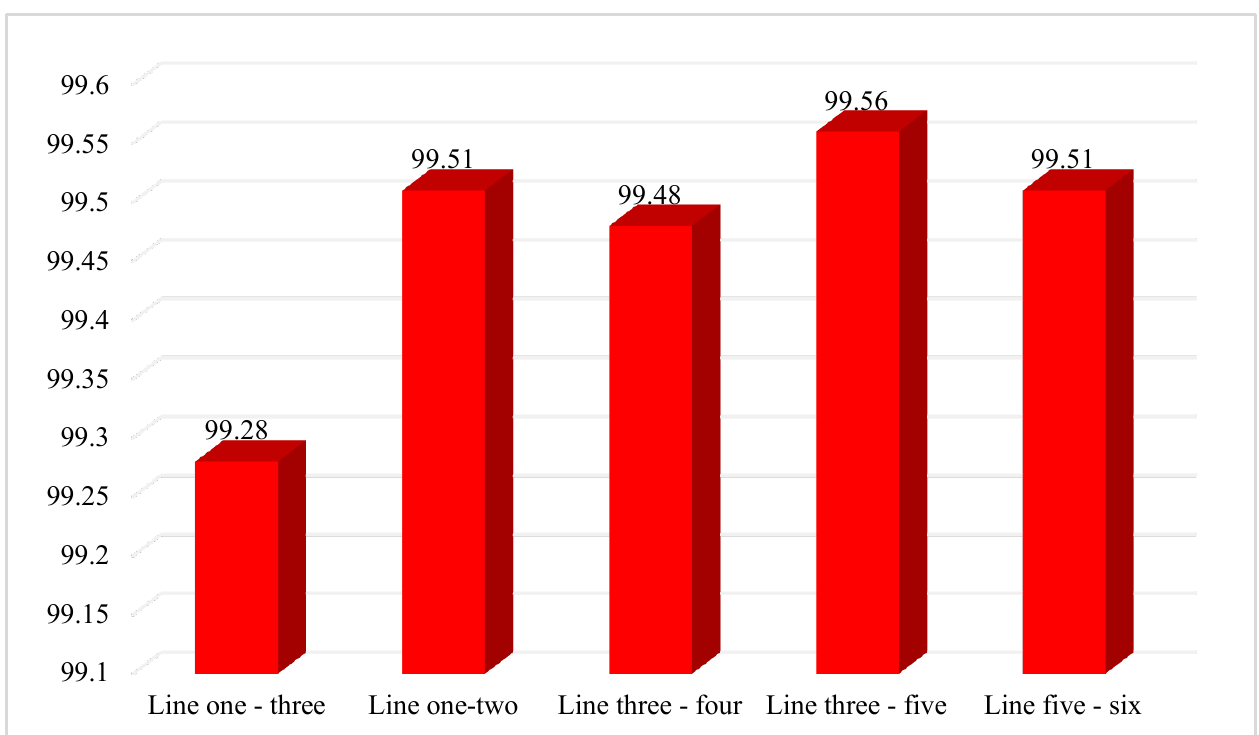
Figure 7. Average accuracy for various system setups. Table 2. Accuracy, sensitivity, and specificity of the proposed classifier.